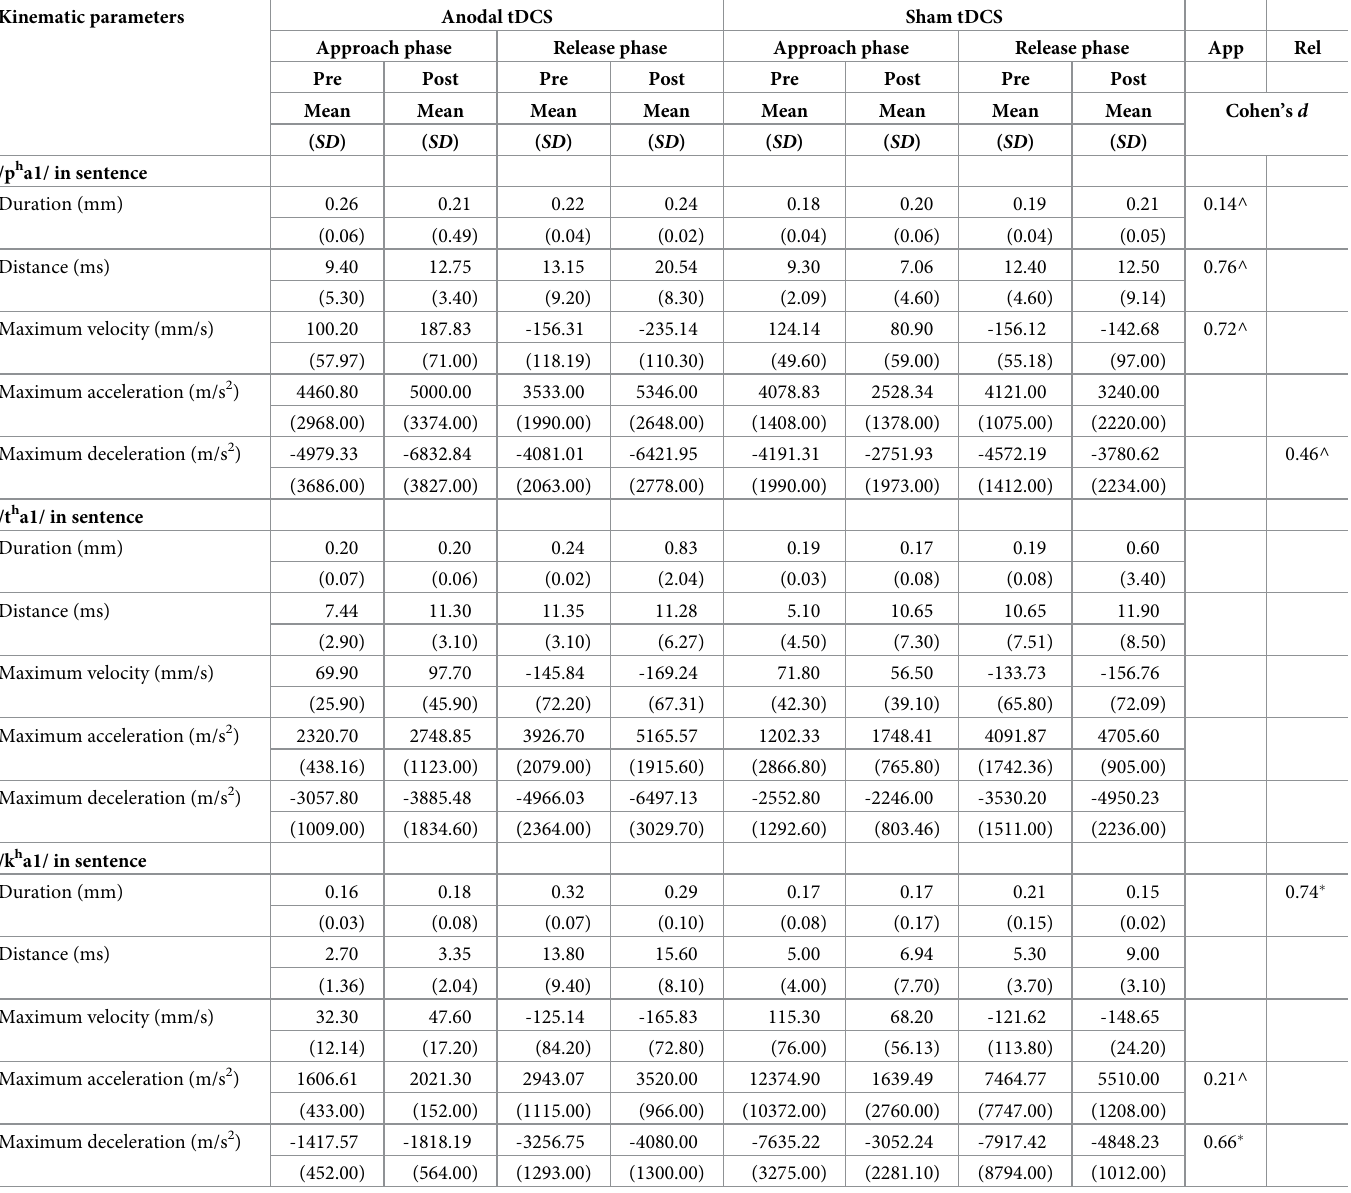
Table 6. Comparison of kinematic parameters (sentence) between the stimulation and sham groups before and after treatment. Kinematic